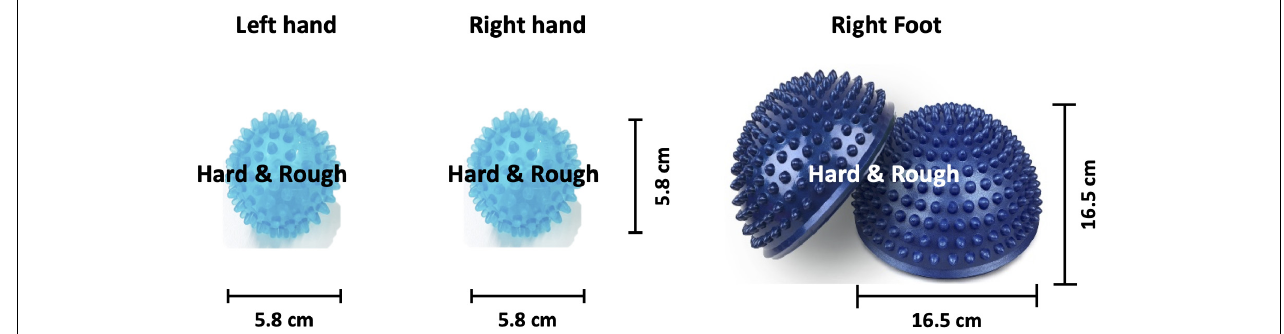
FIGURE 3 | Image of the somatosensory stimulus. Hard and rough tangible balls were used as stimuli for the left and right hands while a hard and rough half-ball was the stimulus for the right foot.